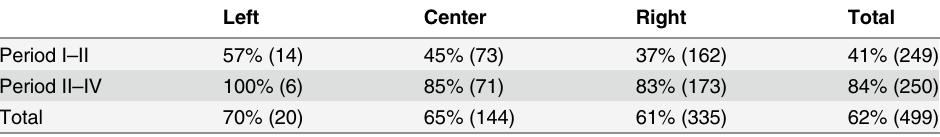
Table 5. Wash-out rates at different positions in the study site during the increasing and decreasing periods. Left Center Right Total Period I – II 57% (14) 45% (73) 37% (162) 41% (249) Period II – IV 100% (6) 85% (71) 83% (173) 84% (250) Total 70% (20) 65% (144) 61% (335) 62% (499) Period I – II is the increasing period, and period II – IV is the decreasing period. Parentheses indicate the numbers of observed individuals. Dates I – IV are de fi ned in the text.